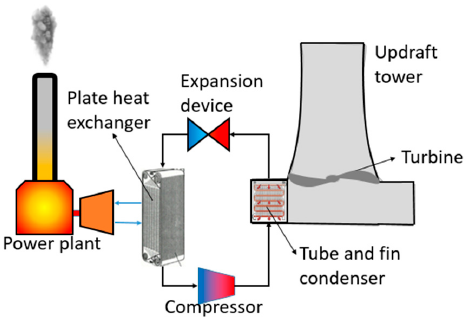
Figure 1. Schematic illustration of an updraft tower system with a vapor compression secondary loop for dry cooling in large-scale power plants.